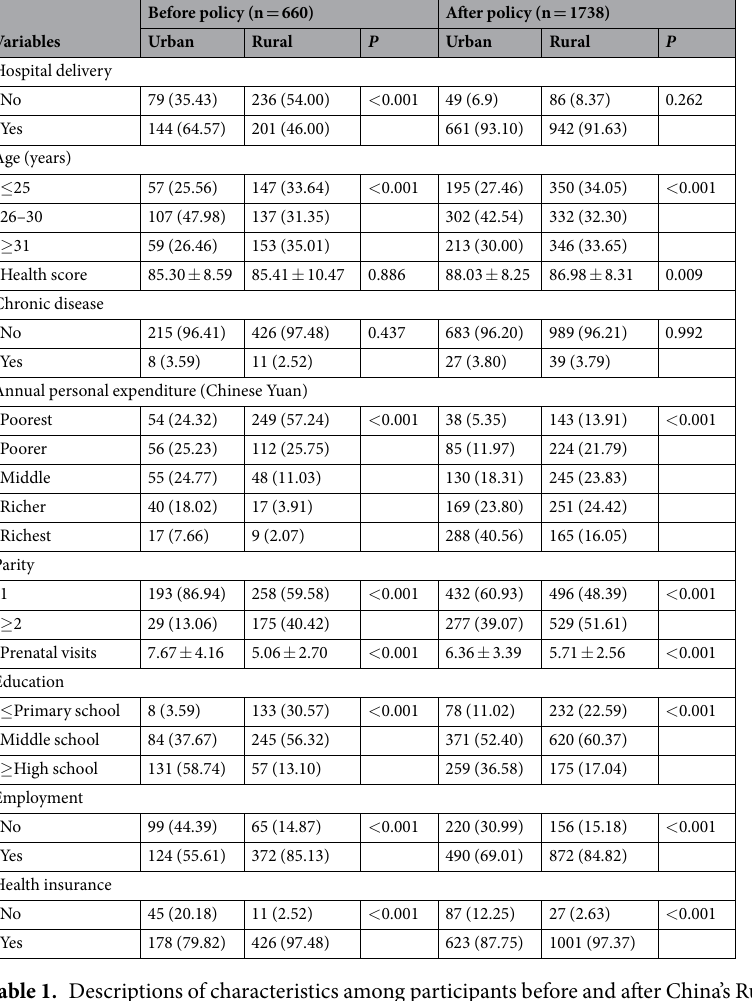
Table 1. Descriptions of characteristics among participants before and after China’s Rural Hospital Delivery Subsidy [ x ± sd /n (%)]. x : mean; sd : Standard